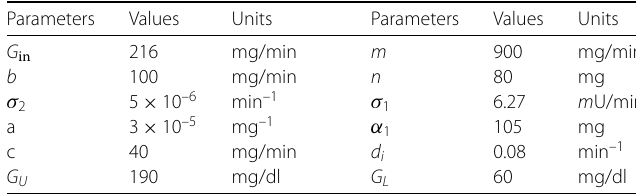
Table 1 Model parameter values from [4]